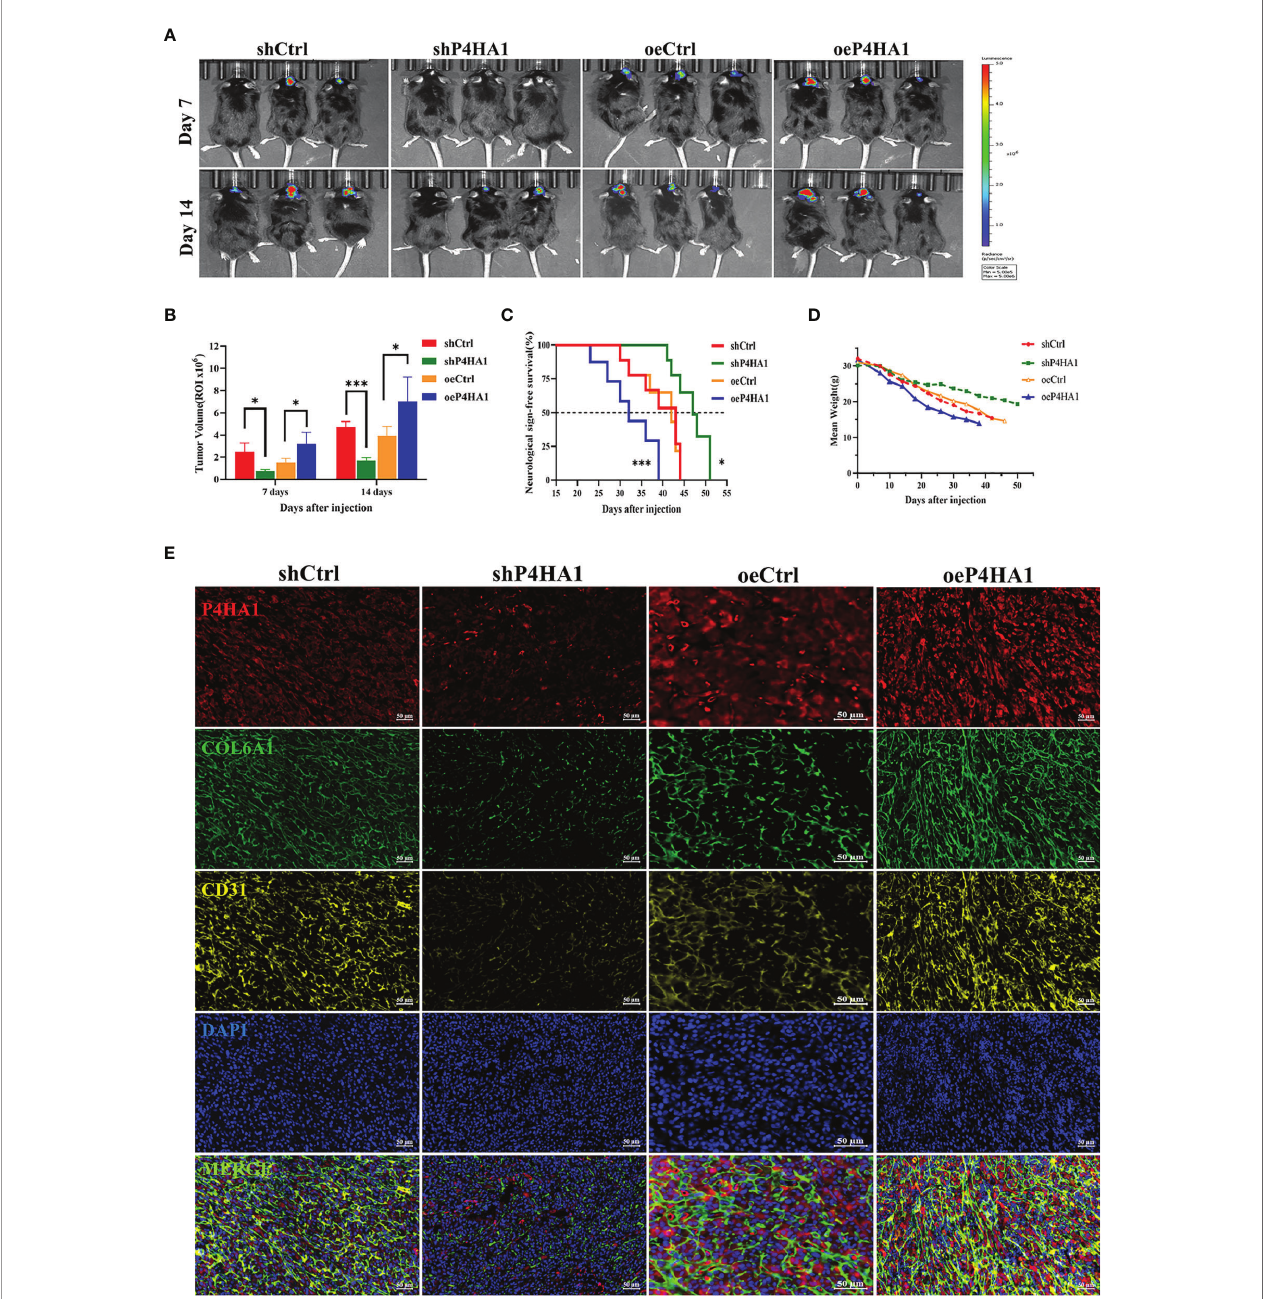
FIGURE 7 | P4HA1 promotes glioma progression and expression of COL6A1 and CD31 in vivo. (A) In vivo imaging shows glioma growth 7 days and 14 days after injection of 1.5x10 5 GL261 GSCs-Luc with different levels of P4HA1 into each mouse brain. (B) Intracranial tumors size calculation of (A) . *P < 0.05, ***P < 0.001. (C) Kaplan-Meier survival curve of mice implanted with GSCs transduced with shCtrl, shP4HA1, oeCtrl, oeP4HA1 lentiviral vector (n = 6 mice for per group). Log- rank test, *P<0.05, ***P<0.001. (D) Mice weight loss curve within 50 days post-implantation. (E) Polychromatic tissue immuno fl uorescence immunoassay in mouse tissue sections showed that the expression of P4HA1, COL6A1 and CD31 in mouse glioma was positively correlated and signi fi cantly co-located (scale =50